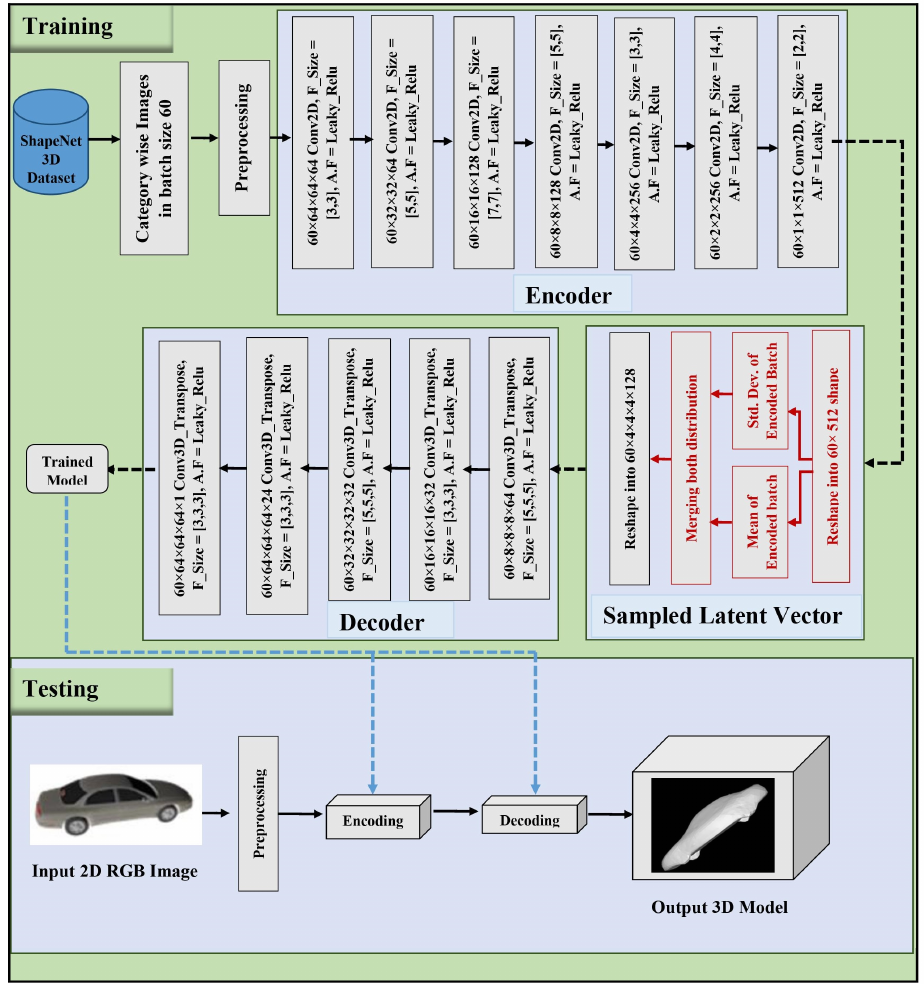
Figure 3. Detailed Architecture of the Proposed Variational Autoencoder